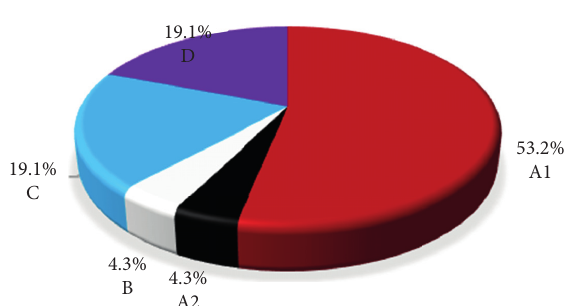
Figure 1: The proportion of HIV-1